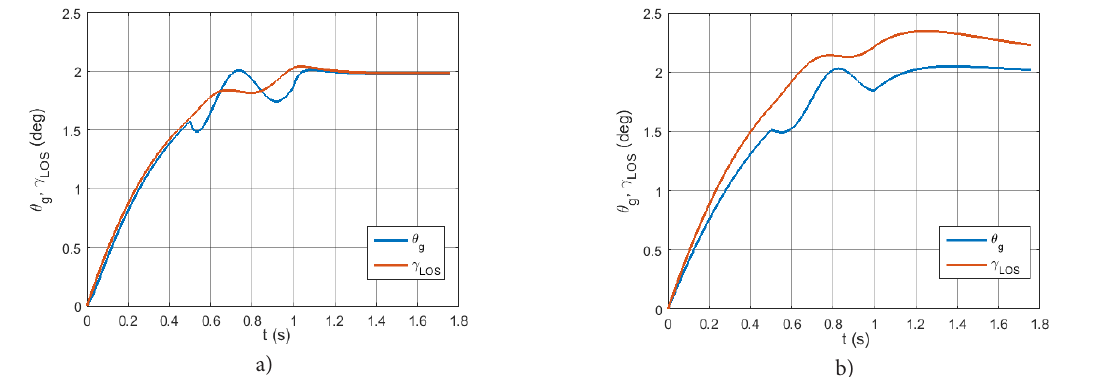
Figure 10. Pitch angle for LOS and gyroscope system axis, for: a) LQR, b) PD regulator